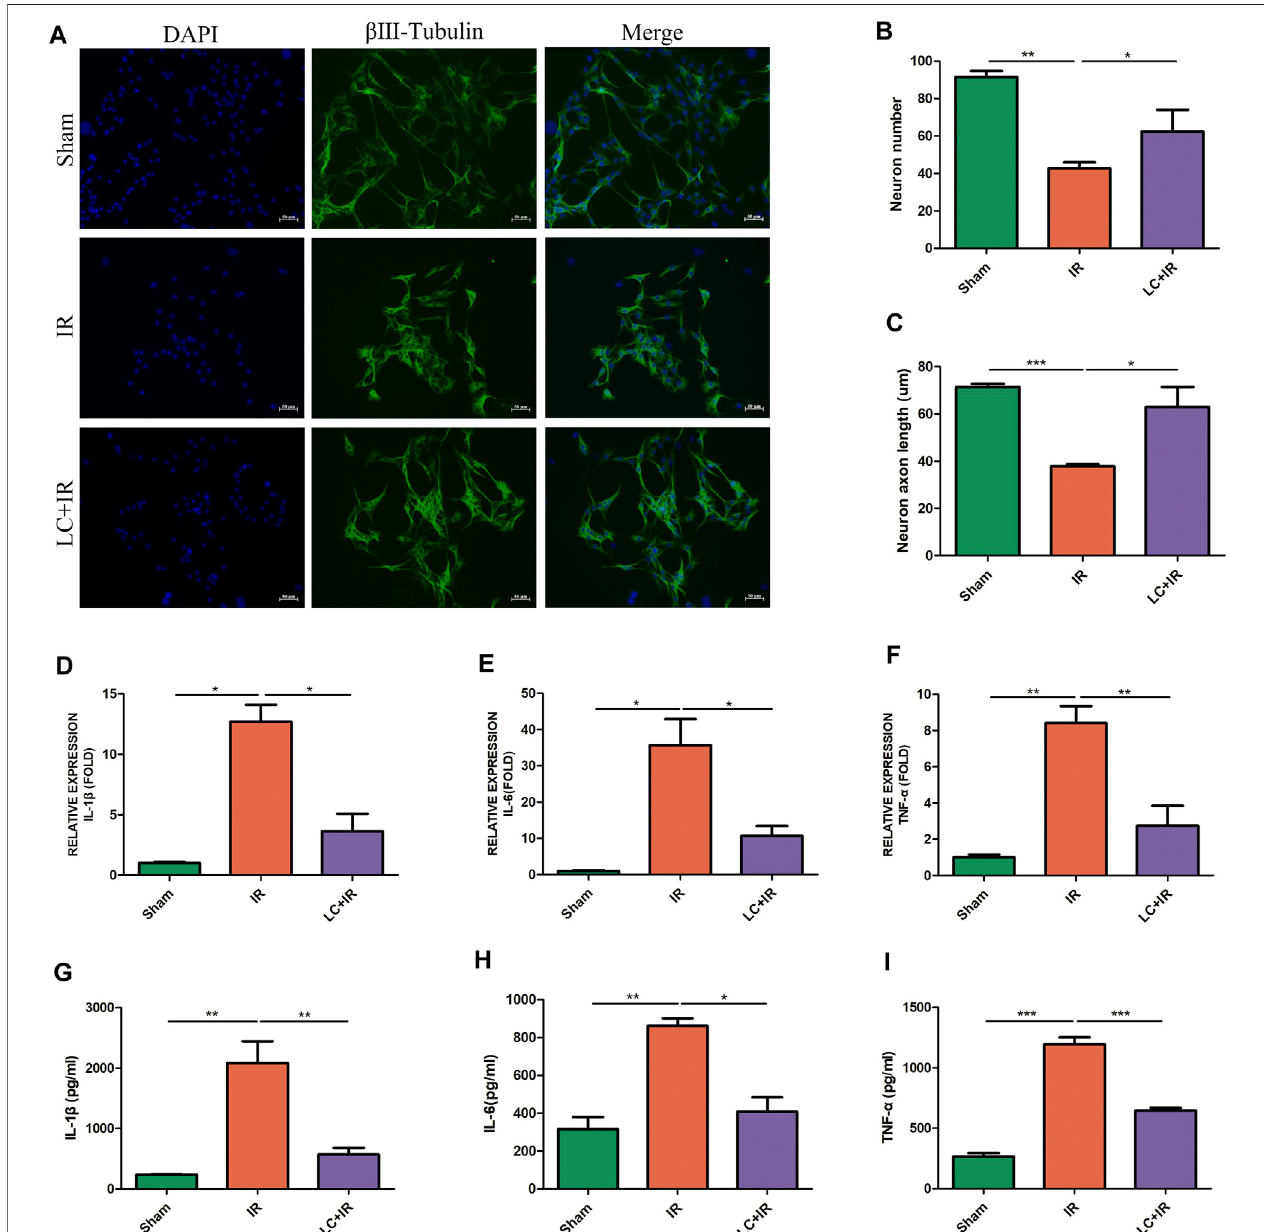
FIGURE1| L-Cysalleviatedtheinjuryofmyentericneuronsandtheincreaseinpro-in fl ammatoryfactorsinducedbyintestinalIR.AftertheIRmodelwasperformed, (A) intestinalmyentericneuronswereisolatedandculturedfor6days invitro forimmuno fl uorescencestainingwithrepresentativeimagesof β Ⅲ -tubulin(green)andDAPI (blue). Scale bar = 50 μ m. N = 4 /group. (B,C) Quantitative analyses of the number of neurons and the length of axons. Six randomly captured images per animal were analyzed for each group. N = 4 /group. (D – F) The mRNA levels of pro-in fl ammatory factors IL-1 β , IL-6, and TNF- α in LMMP were detected by qRT-PCR. N = 5 / group. (G – I) Protein levels of pro-in fl ammatory factors IL-1 β , IL-6, and TNF- α in LMMP were detected by ELISA. N = 4 /group. Values are mean ± SEM , * p < 0.05, ** p < 0.01, and *** p < 0.001 according to ANOVA with the Newman – Keuls test.